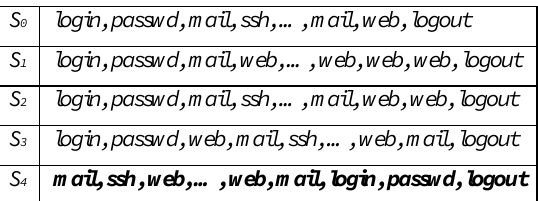
Table 1. Sequences of user